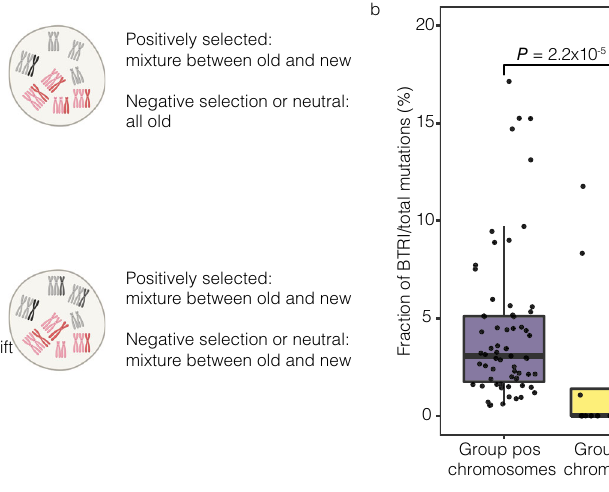
mutationsingroupsstrong-pos/weak-posversusgroupnegtrisomiesin67casesof HeH ALL. Groups strong pos/weak trisomies have a higher fraction of BTRI muta- tions ( P =2.2×10 − 5 Mann – Whitney two-sided test), indicating that they are on average newer, consistent with an initial tripolar cell division followed by clonal evolution. The centre of the boxplot is the median and lower/upper hinges corre- spond to the fi rst/thirdquartiles; whiskersare1.5 timesthe interquartile rangeand data beyond this rangeare plottedasindividualpoints. Figure 4a wascreated with BioRender.com. Source data are provided as a Source Data fi